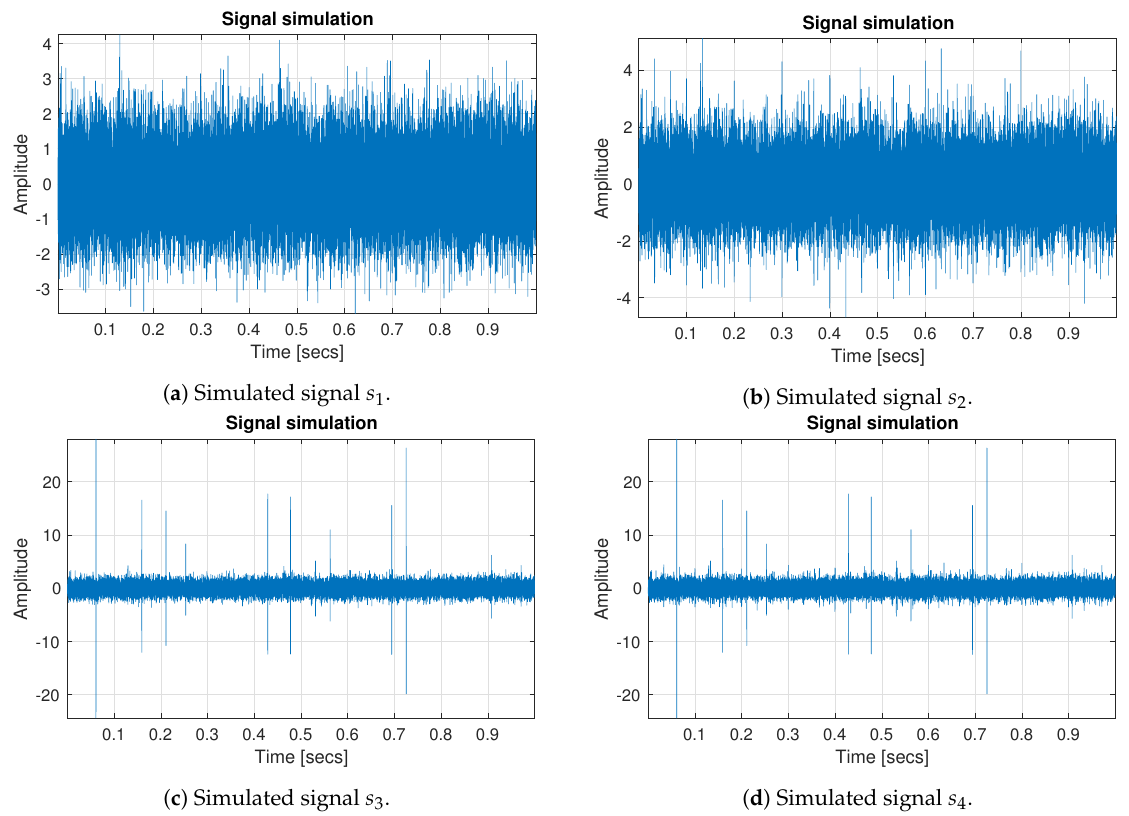
Figure 1. Exemplarysimulations of the considered signals: ( a ) Gaussian White Noise, ( b ) Gaussian White Noise with the cyclic impulses added, ( c ) Gaussian White Noise with non-cyclic impulses added, ( d ) Gaussian White Noise with cyclic and non-cyclic impulses